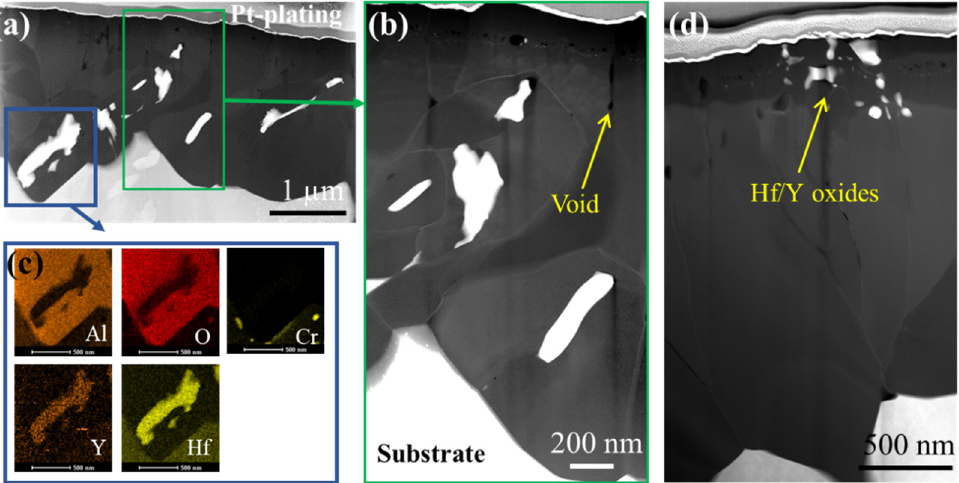
Figure 7. Morphology of the oxide scale on the NiCrAlYHf alloy (cut by FIB) after 100 h at 1100 °C in air–water vapor ( a , d ), local enlarged image ( b ), and EDS analysis ( c ).